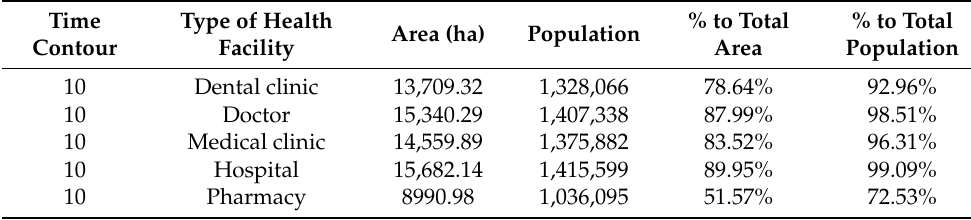
Table 6. Service Range of Health Facilities in 10-Minute Drive.